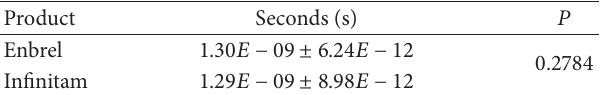
Table 7: Intrinsic Trp fluorescence lifetime measure using TCSPC for Etanercept products. Dispersion values are presented in SD ( 𝑛 = 9